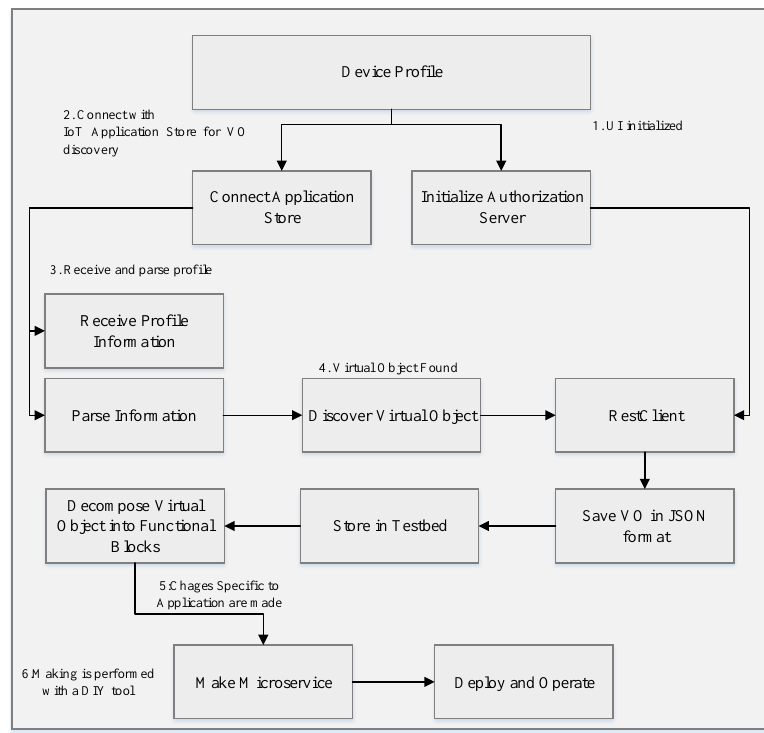
Figure 16. Flow of operation in the use case